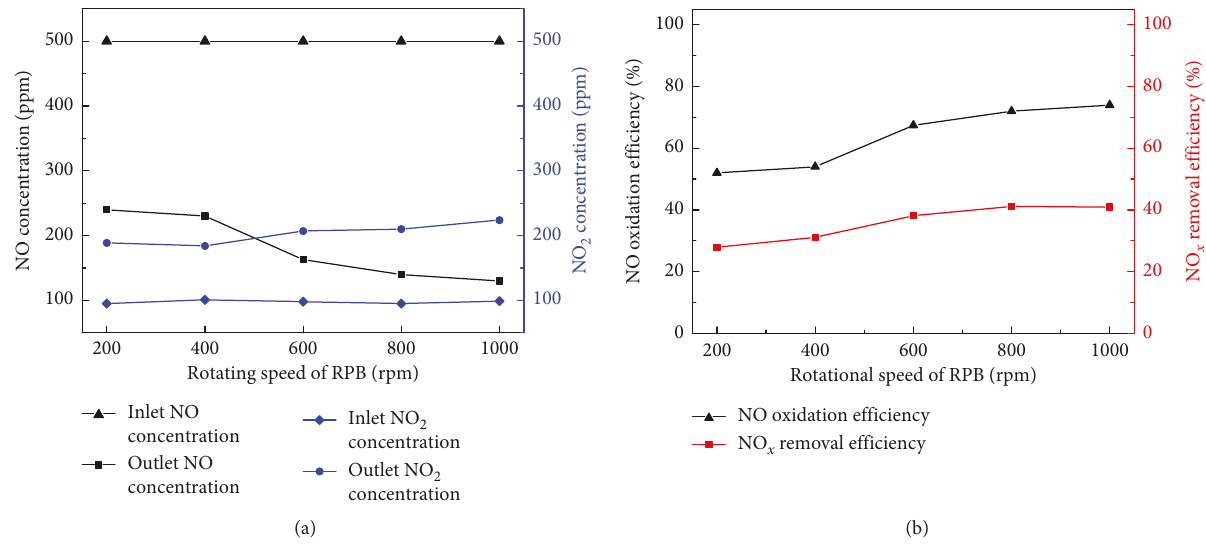
Figure 2: Changes of NO